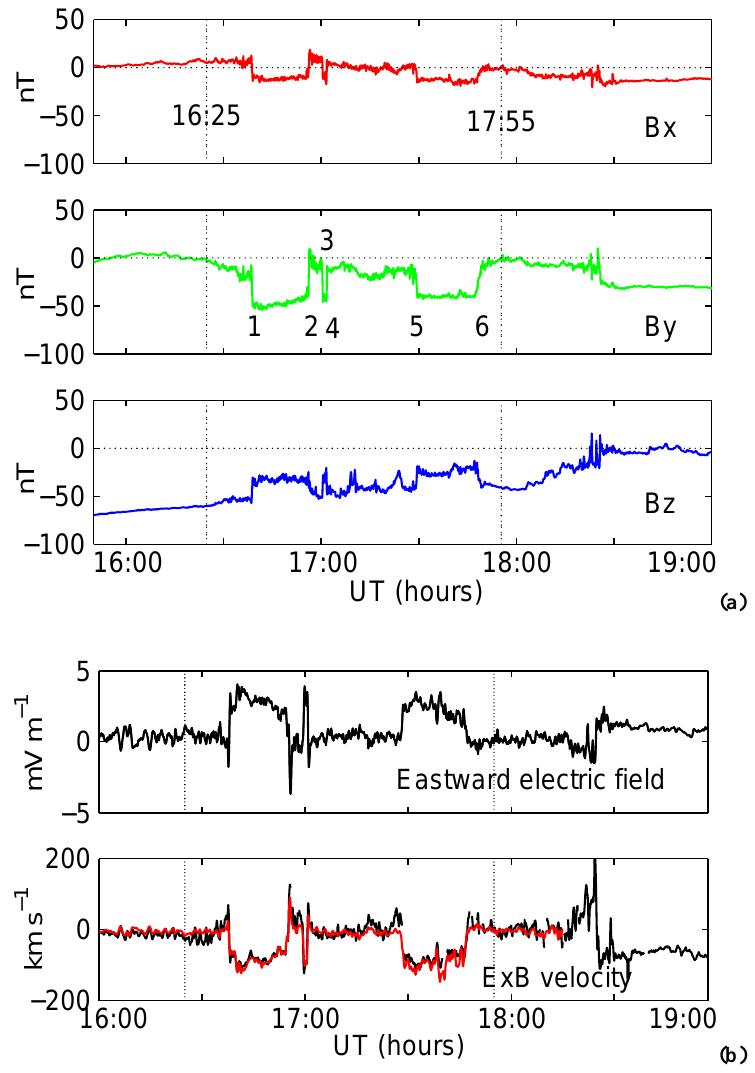
Fig. 5. (a) Magnetic field components B x , B y and B z (bottom panels) from FGM on Cluster SC3 during 15:50–19:00 UT on 18 April 2002. The cusp crossing period (16:25–17:55 UT) is marked between the vertical lines. The inward and outward boundaries of the anti-sunward ion flow events (a, b and c) are numbered 1 to 6 in B y . (b) : Eastward (positive) electric field measured by EFW on Cluster SC3 during 16:00–19:00 UT on 18 April 2002 (top). The bottom panel compares the calculated (red) and measured (black) ion velocity V x . The velocity is calculated ( V x = E y × B z ) using the electric field E y in the top and magnetic field B z in Fig.